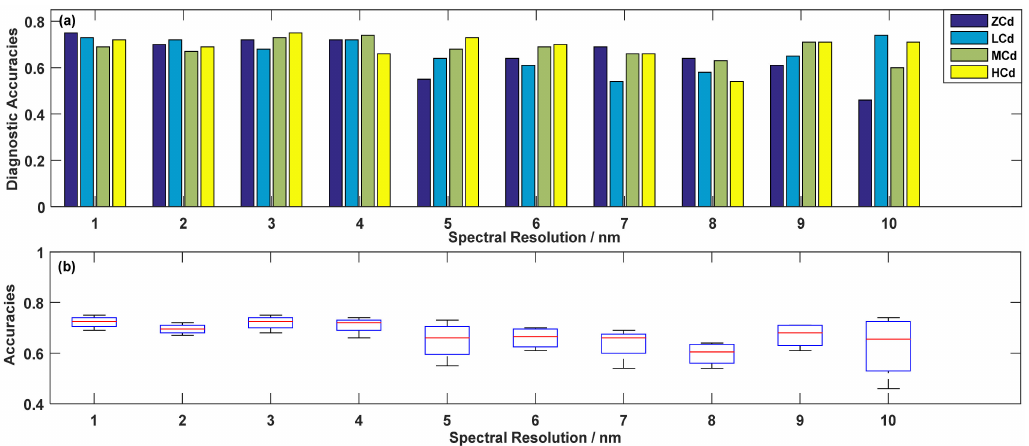
Figure 7. Optimal accuracies ( a ) and corresponding boxplots ( b ) for diagnosing Cd pollution in di ff erent